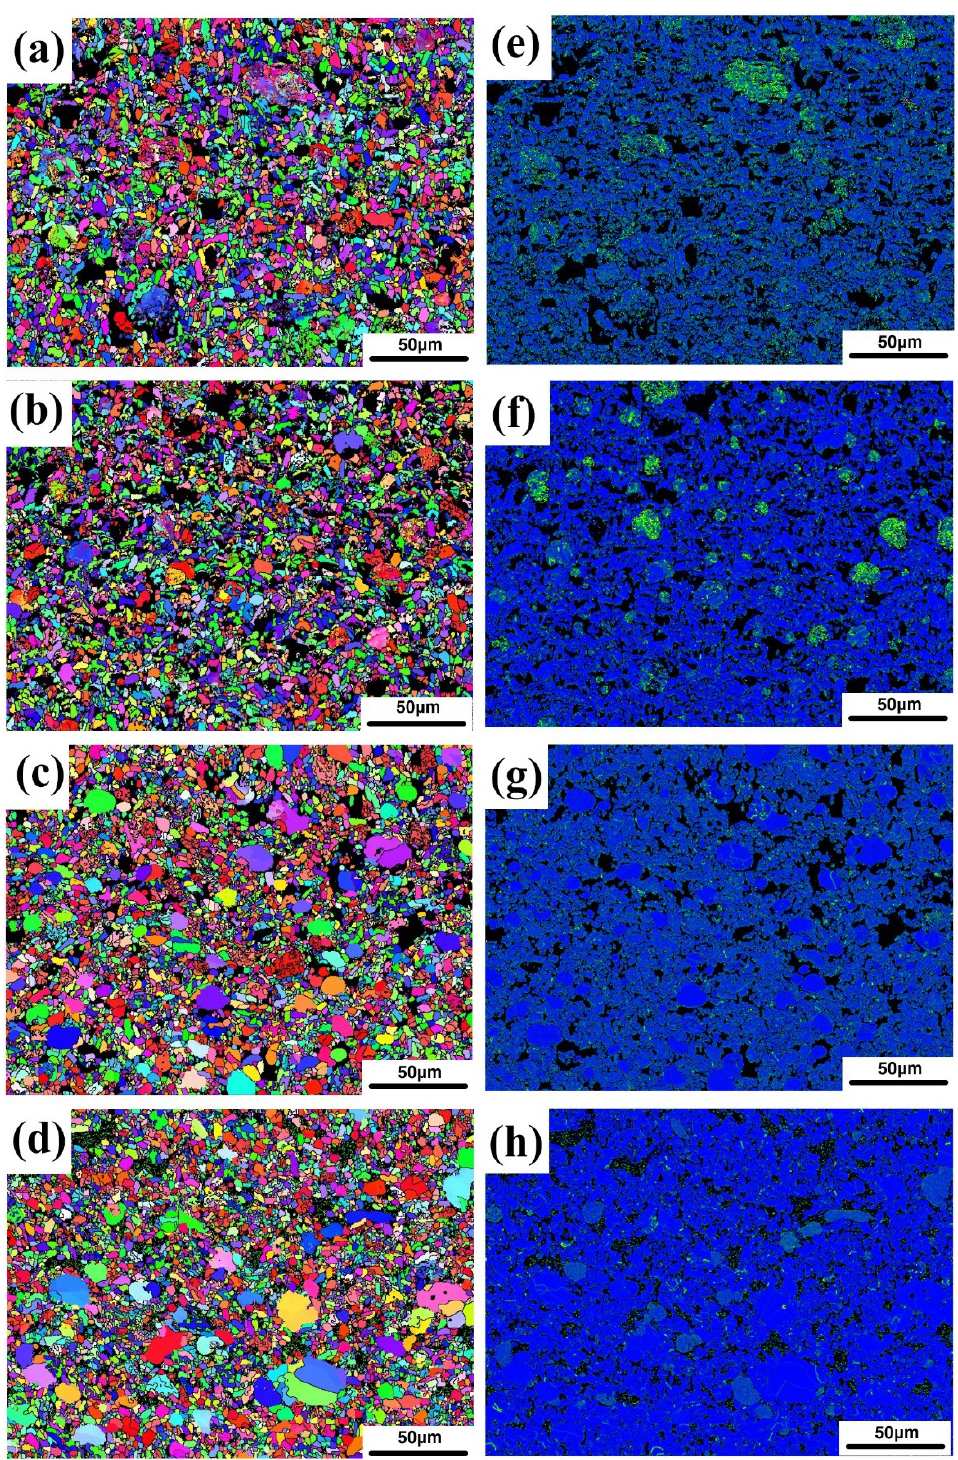
Figure 8. The Inverse Pole Figure X-axis (IPFX) distribution of samples B1 ( a ), B2 ( b ), B3 ( c ), B4 ( d ) and stress distribution of samples B1 ( e ), B2 ( f ), B3 ( g ), B4 ( h ).